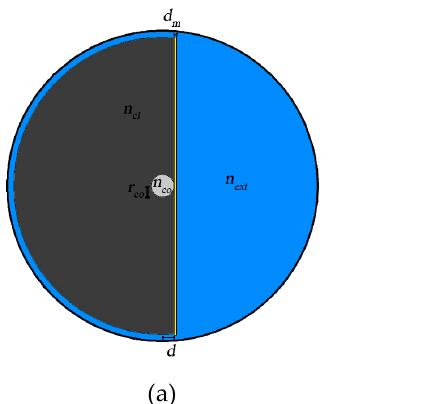
( b ) Figure 3. Normalized Poynting vector amplitude 1D across the fiber core: ( a ) for conventional D-type fiber structure and ( b ) for PCF D-type fiber structure ( n ext = 1.39). For the ranges of n ext of [1.36, 1.38] and [1.38, 1.39], Table 1 compares both sensing configurations. For the conventional D-type fiber configuration, one metallic layer thickness is considered, d m = 45 nm, while for the PCF D-type fiber configuration two metallic layer thicknesses are considered, d m = 45 nm and d m = 65 nm, respectively. The resolution (R) and the sensitivity (S) were obtained considering an experimental spectral variation detection of 0.1 nm and using the data of Figure 2 and the following equations: 𝑆(𝜆) = 𝛥𝜆 (cid:3043)(cid:3032)(cid:3028)(cid:3038) 𝛥𝑛 (cid:3032)(cid:3051)(cid:3047)